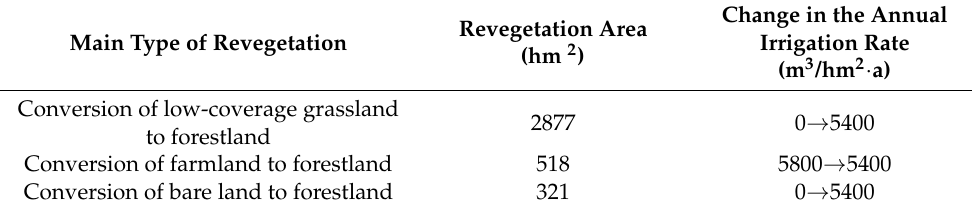
Table 3. Main types of revegetation in the study